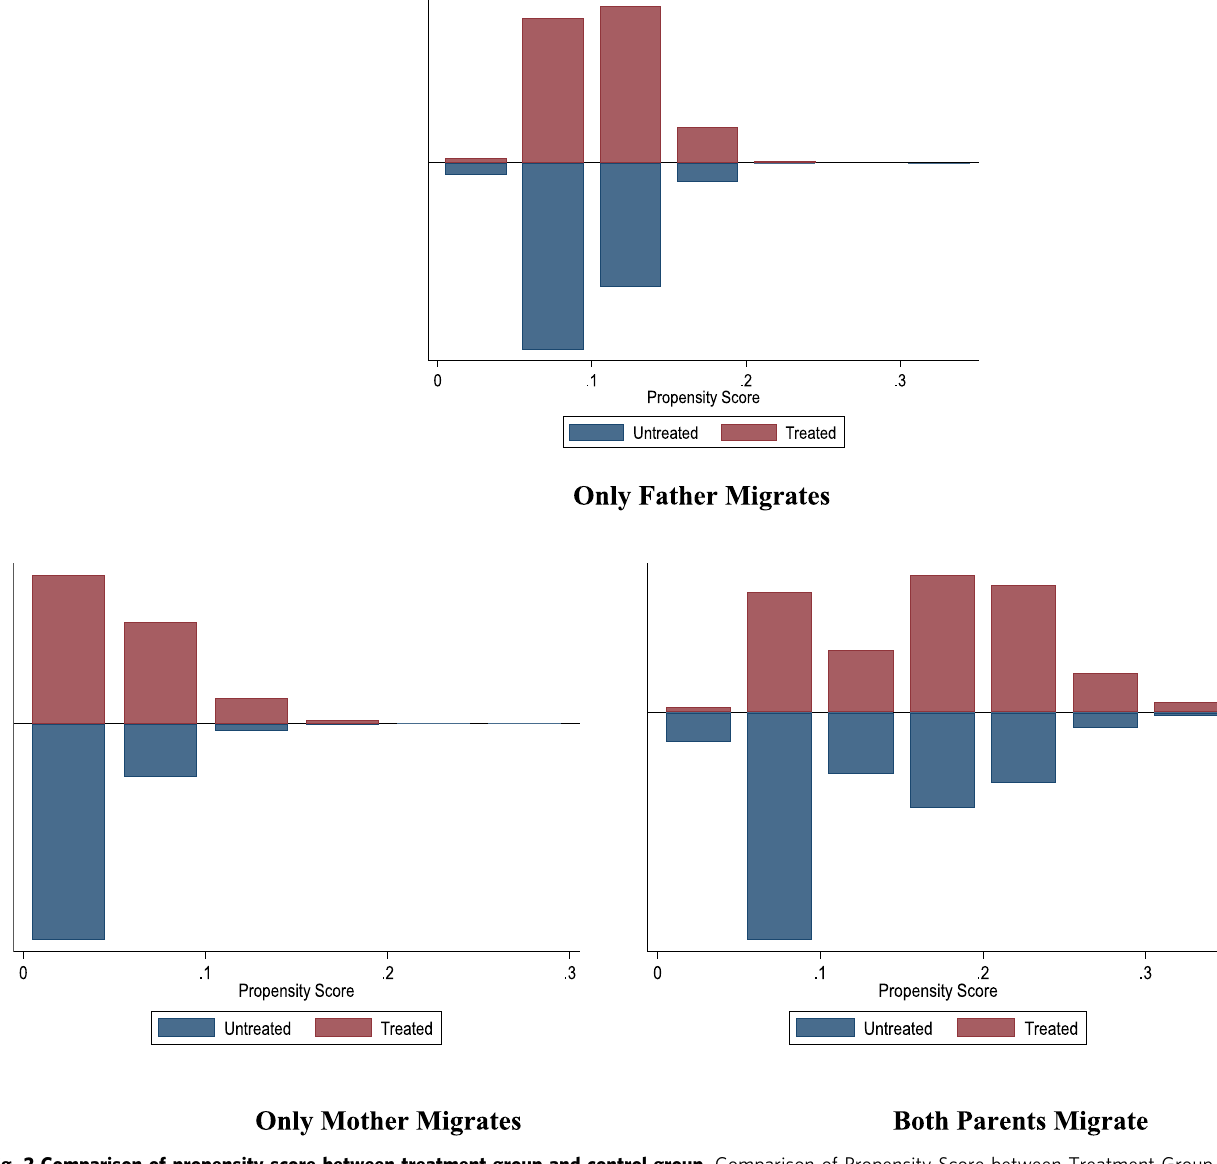
Fig. 2 Comparison of propensity score between treatment group and control group. Comparison of Propensity Score between Treatment Group and Control Group of all the various migration models, namely only the father migrates, only the mother migrates, and both parents migrate.